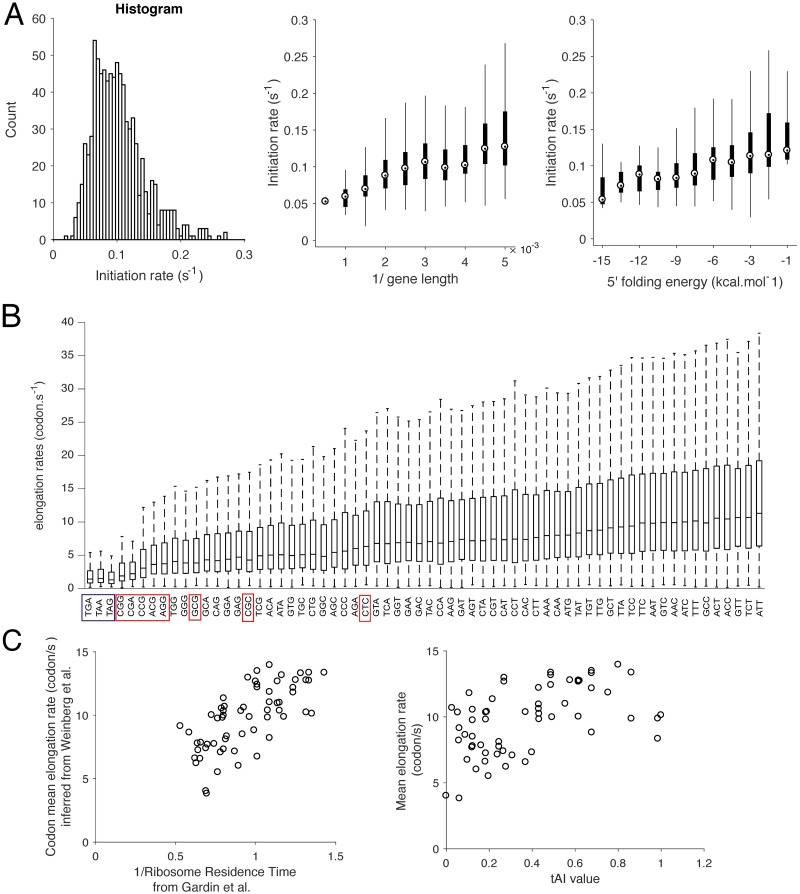
Analysis and comparison of the inferred rates.A. (Left) A histogram of inferred initiation rates. (Middle) Comparison between the inferred initiation rates and the inverse of the ORF length of the gene, showing a positive correlation (r = 0.44, p-value < 10−5, computed for unbinned data). (Right) Comparison between the inferred initiation rates and the 5′-cap folding energy computed in Weinberg et al. [16], showing a positive correlation (Pearson’s correlation coefficient r = 0.2646, p-value < 10−5, computed for unbinned data). The interquartile range is indicated by the box, the median by a point inside the box, and upper and lower adjacent values by whiskers. B. Distribution of codon-specific elongation rates. Stop codons are boxed in blue, while the eight low-usage codons reported by Zhang et al. [75] are boxed in red. C. Comparison between the codon-specific mean elongation rates computed from B and (Left) the inverse of the codon mean “ribosome residence time” (RRT) estimated by Gardin et al. [21], and (Right) the tAI value, computed by Tuller et al. [14].